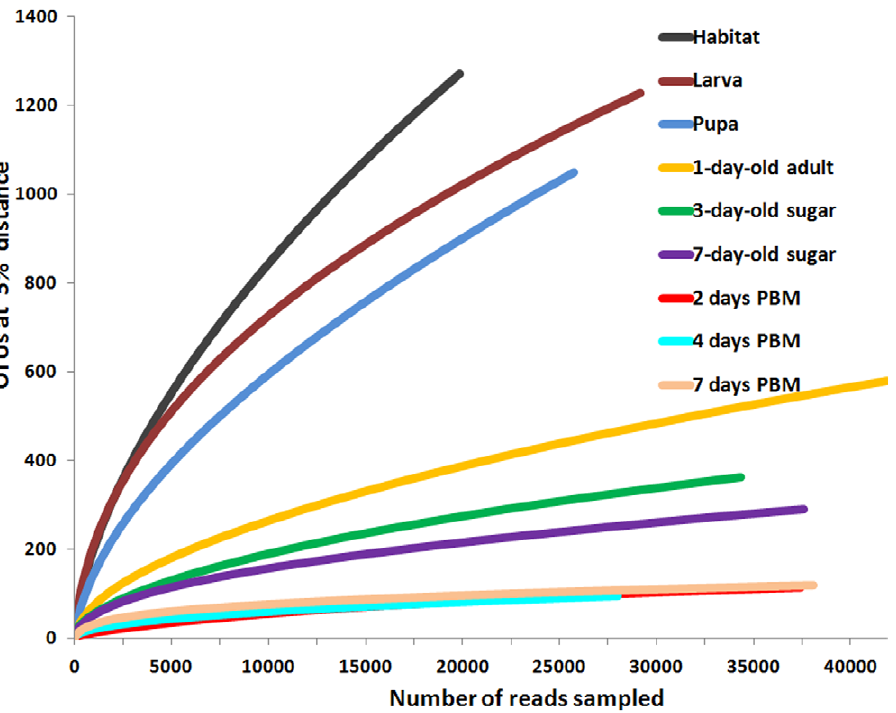
Figure 1. Rarefaction analysis for each sample. OTU s at 5% distance for each site was used to calculate rarefaction curves. Sugar, mosquitoes were fed with sugar meal; PBM, post blood meal.